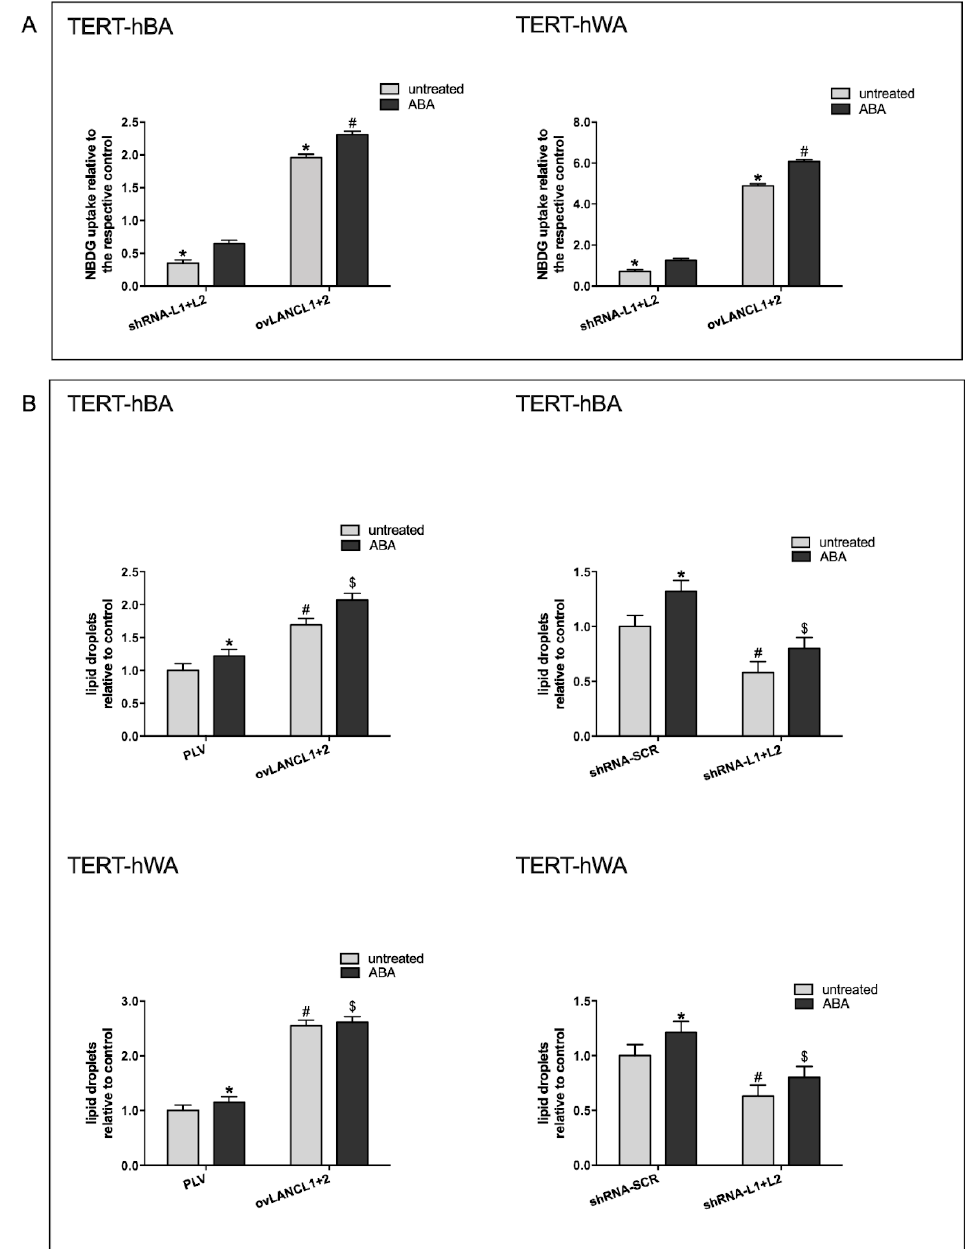
Figure 9. LANCL1/2 expression levels control glucose uptake and affect triglyceride synthesis in white and brown adipocytes. Fully differentiated brown (TERT-hBA) and “beige” TERT-hWA adipocytes overexpressing LANCL1 and LANCL2 (ovLANC1+2), or double-silenced for the expres- sion of both proteins (shRNA-L1+L2), and their respective controls, cells infected with the empty vector (PLV) or cells infected with the scrambled silencing sequences (shRNA-SCR), were analyzed for glucose transport and for triglyceride content. Cells were normalized to total cellular protein content by Bradford assay. ( A ) Glucose transport assays; cells were serum-starved for 12 h, then treated with 100 nM ABA for 5 min prior to incubation with the fluorescent glucose analog 2-NBDG. Results are expressed as NBDG uptake relative to the respective, ABA-untreated control (shRNA-SCR for silencing and PLV for overexpression, not shown in the figure). TERT-hBA, left panel; TERT-hWA, right panel. * p < 0.0004 relative to the respective untreated control; # p < 0.001 relative to the respec- tive ABA-treated shRNA-SCR or PLV-infected cells. All results are the mean ± SD from at least 3 separate experiments. ( B ) Triglyceride content; triglycerides were stained with Oil Red O